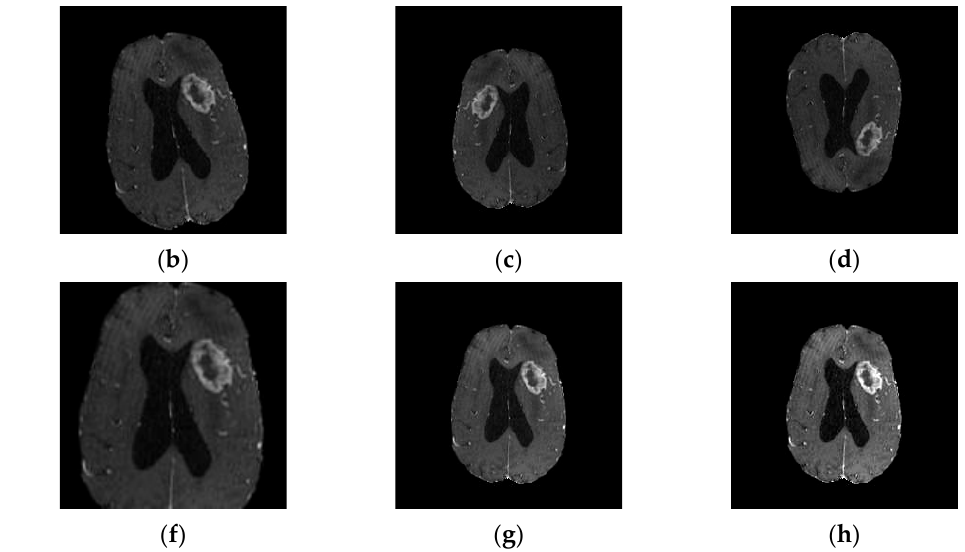
Figure 3. Data augmentation : ( a ) original image; ( b ) 18° rotation. When rotating by an arbitrary number of degrees (non-modulo 90), rotation will result in the image being padded in each corner. Then, a crop is taken from the center of the newly rotated image to retain the largest crop possible while maintaining the image’s aspect ratio; ( c ) left–right flipping; ( d ) top–bottom flipping; ( e ) scaling by 1.5 times; ( f ) cropping by center cropping to the size 150 × 150; ( g ) random brightness enhancement; ( h ) random contrast enhancement.